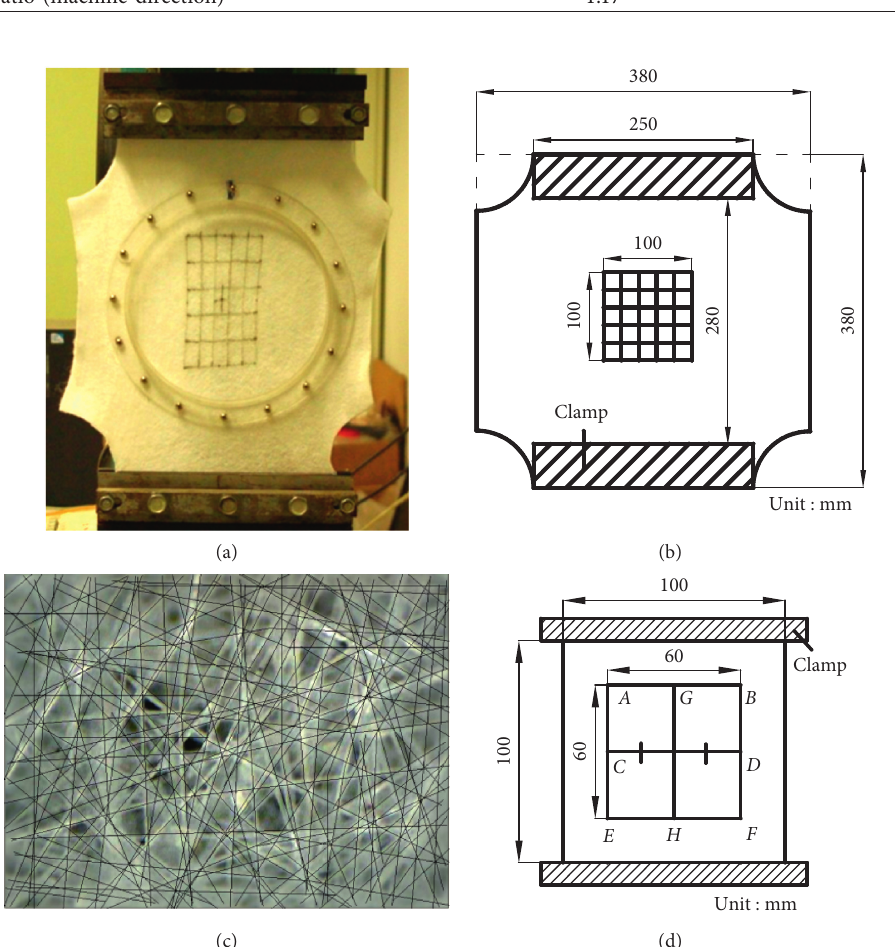
Figure 2: Preparation of strained geotextile specimen. (a) Photograph of strained geotextile specimen secured by clamps. (b) Schematic of an unstrained specimen for the dry sieving test. (c) Measurement of fibre orientations. (d) Schematic of unstrained specimen for the in-plane Poisson’s ratio test.